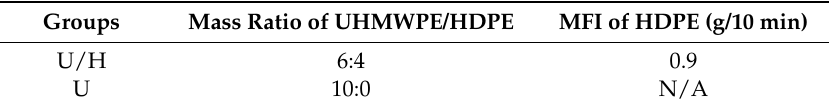
Table 1. Parameters of UHMWPE/HDPE blend.